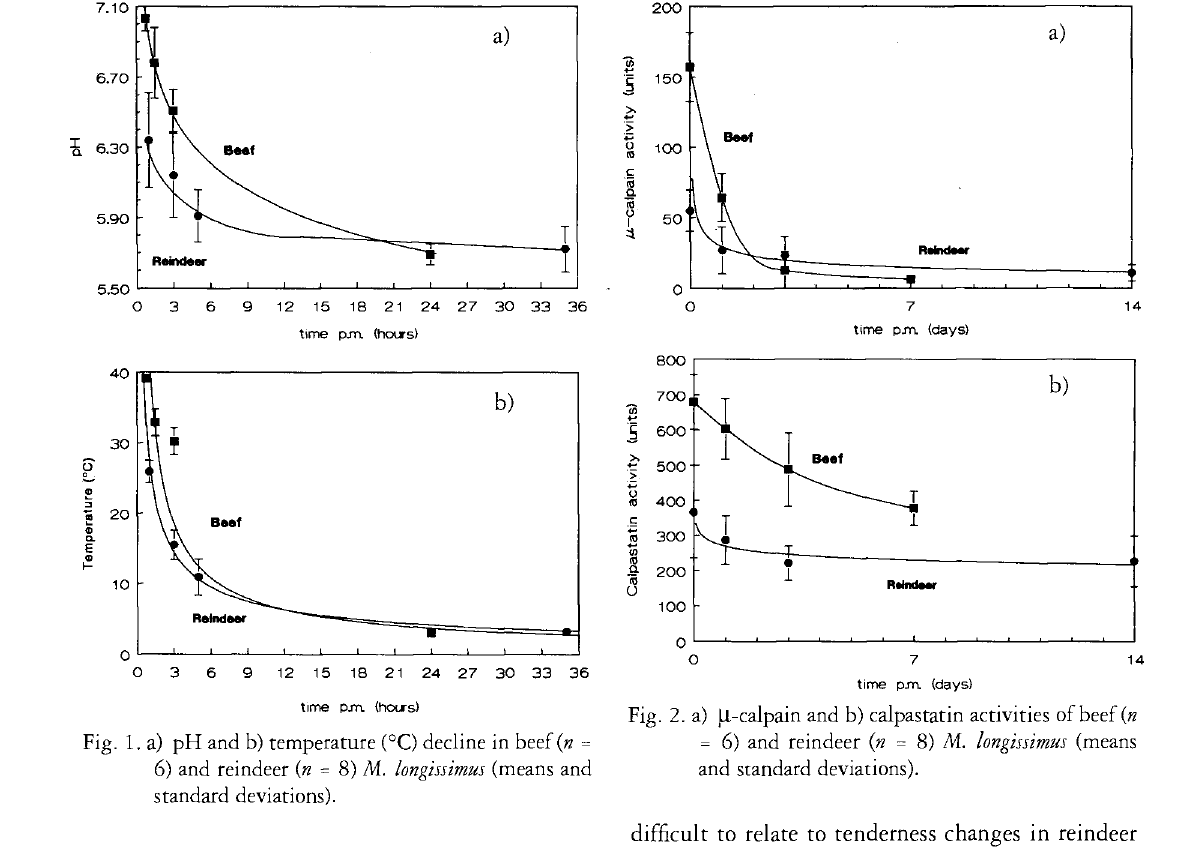
Fig. 2. a) |I -calpain and b) calpastatin activities of beef (n = 6) and reindeer (» = 8) M. longissimus (means